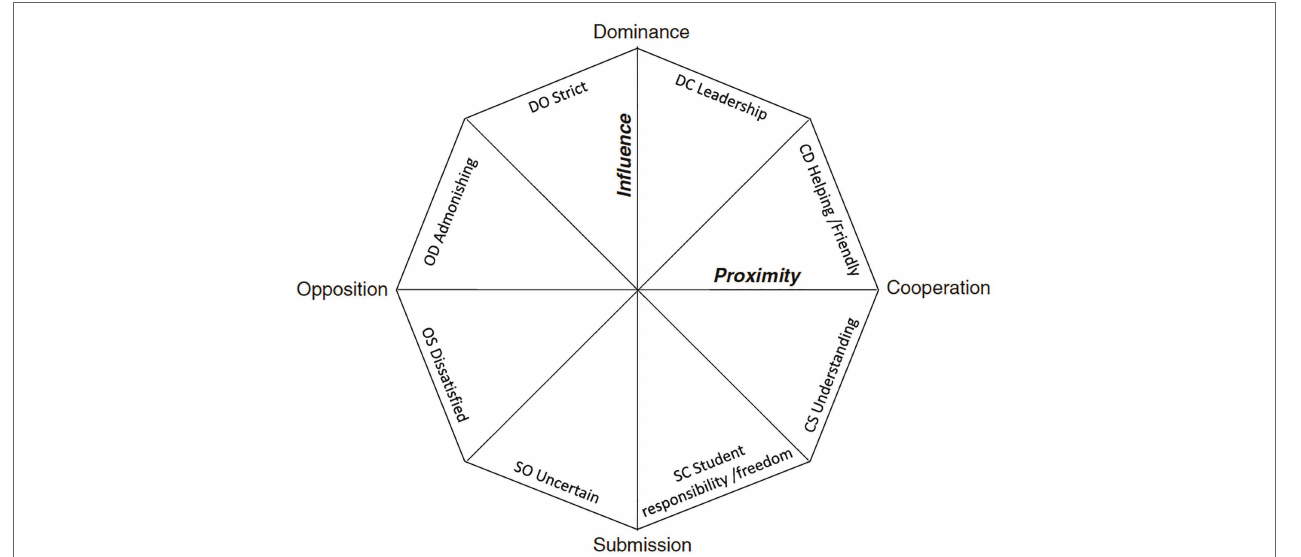
FIGURE 1 | Mainhard et al. (2009) model for supervisor interpersonal